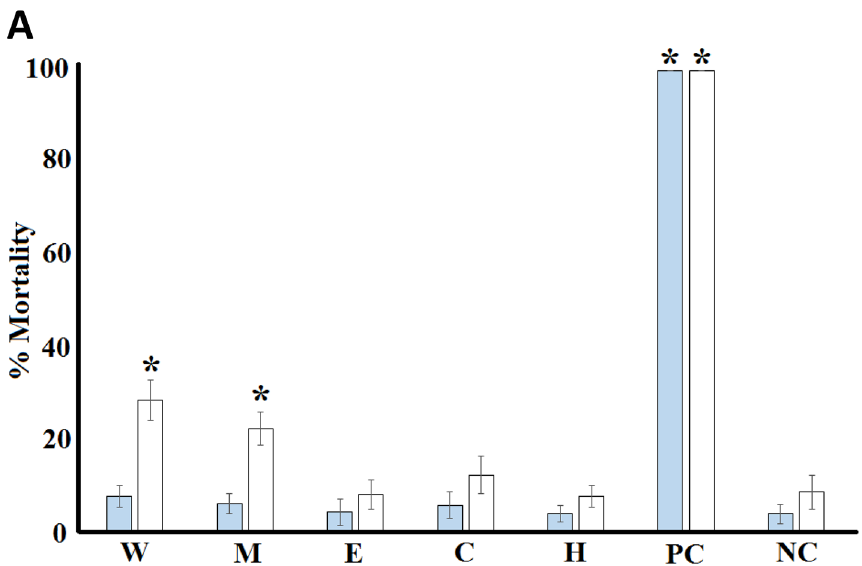
Figure 1. The toxicity of the Handroanthus impetiginosus (Mart. ex DC.) Mattos (Bignoniaceae) bark extracts. Potassium dichromate control (1000 µg/mL) and seawater (negative control) were included as controls. Shaded bars represent the mortality induced by the Handroanthus impetiginosus (Mart. ex DC.) Mattos (Bignoniaceae) extracts following 24 h exposure; open bars represent the mortality induced by the Handroanthus impetiginosus (Mart. ex DC.) Mattos (Bignoniaceae) extracts following 48 h exposure. All bioassays were performed three times in triplicate (n = 9) and are expressed as mean ± SD. M methanolic extract, W aqueous extract, E ethyl acetate extract, C chloroform extract, H hexane extract, PC potassium dichromate control, NC seawater (negative control). *Indicates results that are significantly different than the untreated (seawater) control at the equivalent exposure time (p <